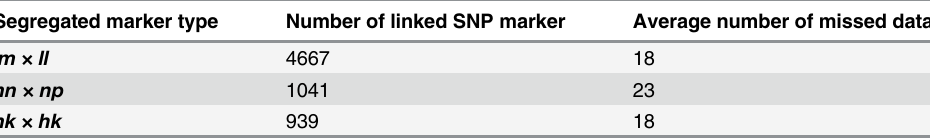
Table 2. Number of candidate SNP markers involved in S . maximus linkage